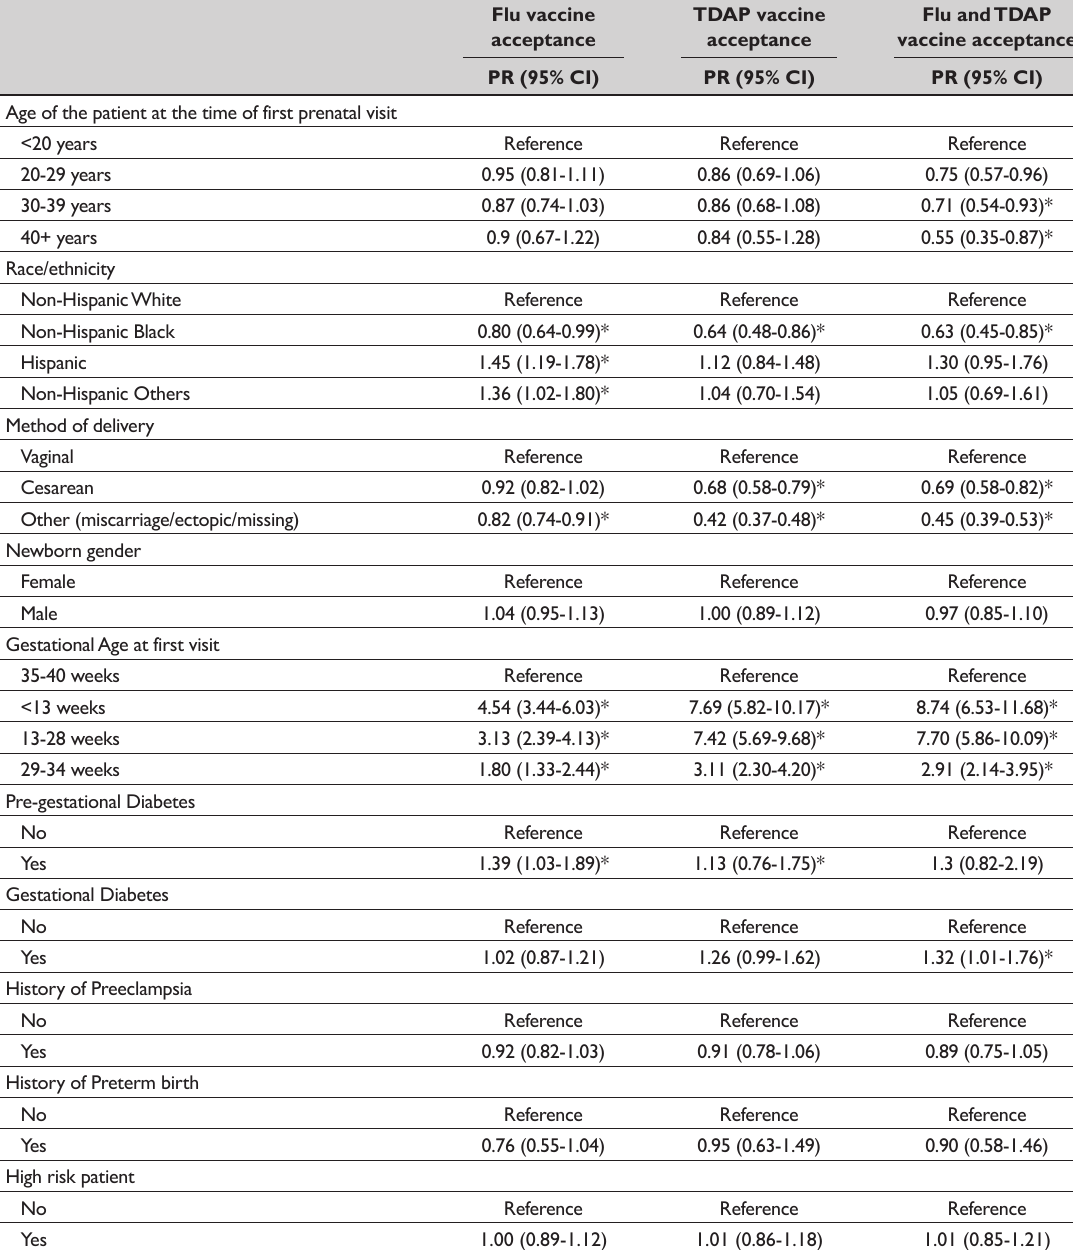
Table 2: Factors associated with Flu, TDAP and both Flu+TDAP vaccine